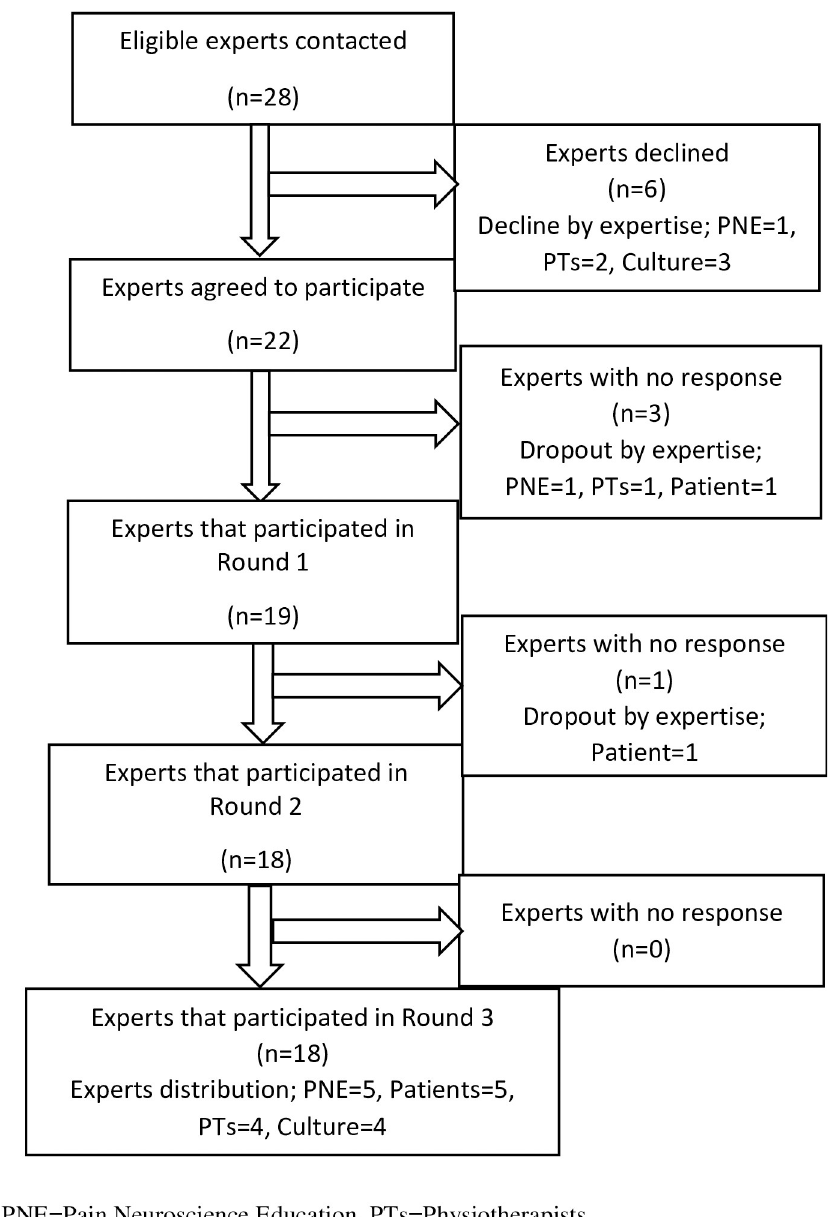
Fig 1. Flow chart of the experts’ recruitment and participation for the Delphi